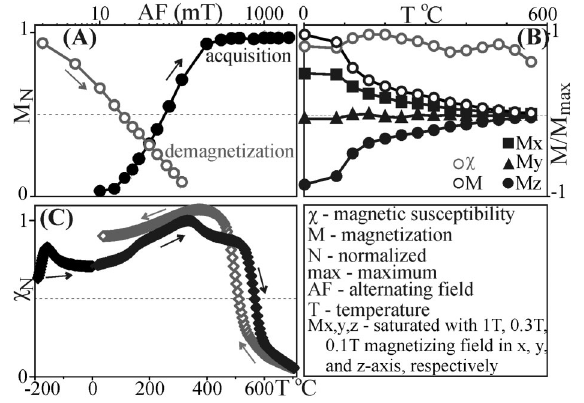
Fig. 2. Examples of ( A ) acquisition and demagnetization of saturation remanence, ( B ) Lowrie method: showing the thermal demagnetization of isothermal remanent magnetization components and ( C ) temperature dependence of magnetic susceptibility.